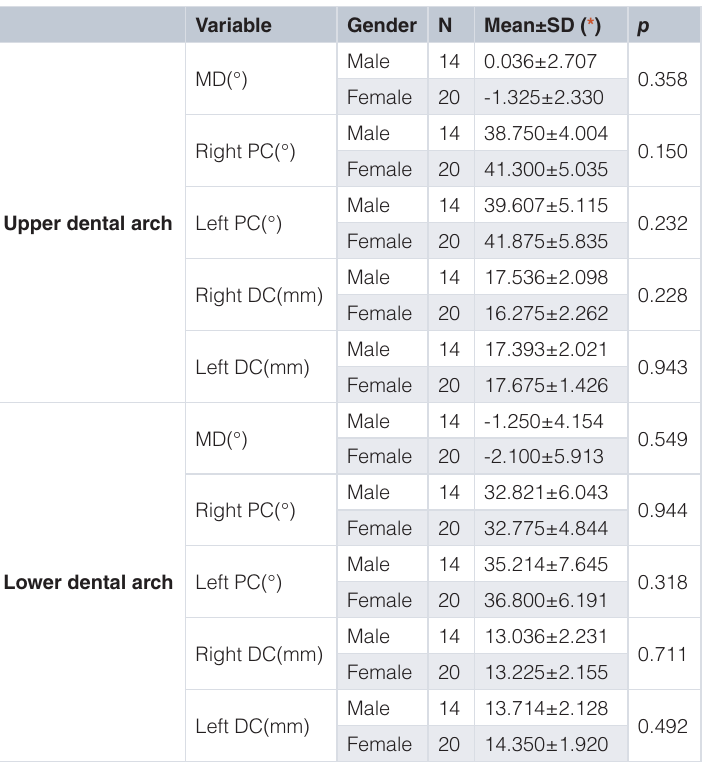
Table 2. Difference of angular and linear measurement for symmetrical analysis in upper and lower dental arch based on